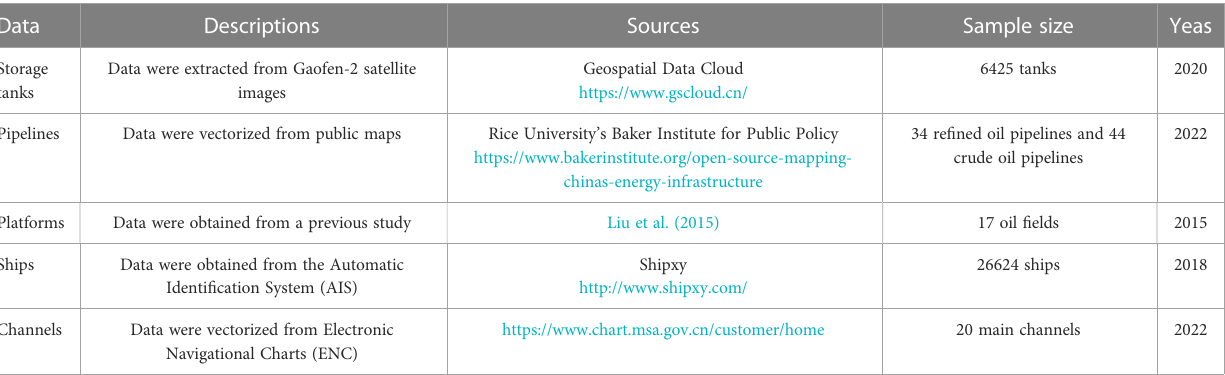
TABLE 1 Overview of data